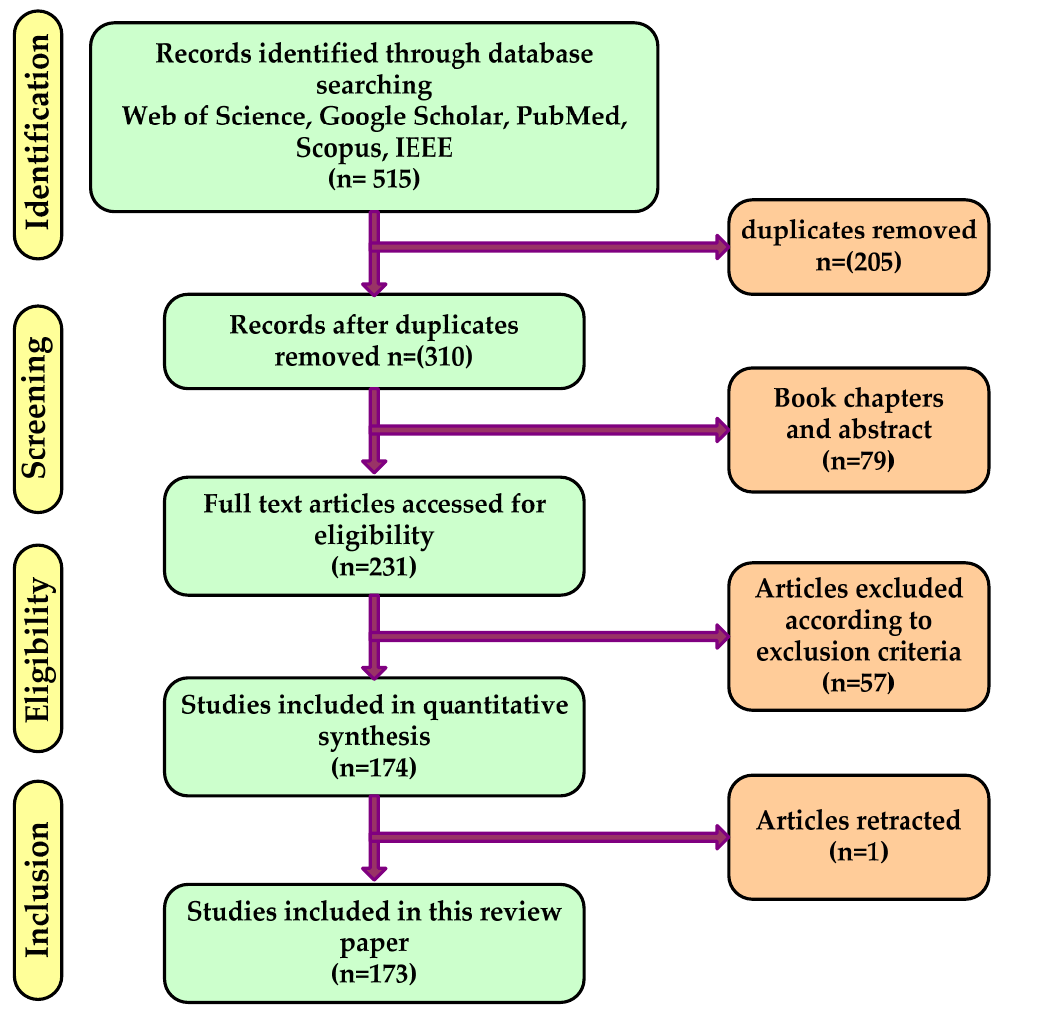
Figure 2. PRISMA